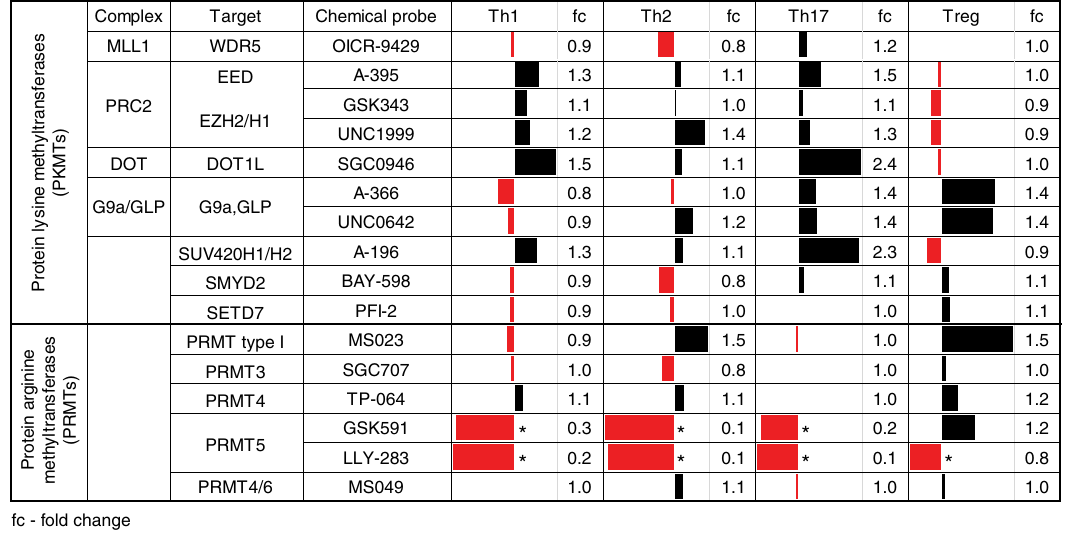
Fig. 6 Overview of PMT Inhibition on Murine CD4 + T cell Differentiation. Data is presented as fold-increase (black) or decrease (red) of cytokine production (IFN- γ , IL-13, and IL-17A for Th1, Th2, and Th17 cells, respectively) or FOXP3 expression (Treg cells) over that of the control compound-treated (or untreated) cells. Data shown are from two to three individual experiments with three biological replicates each. *Signi fi cant cell death: * p < 0.05 compared to DMSO control. See also Supplementary Figs. 6 and